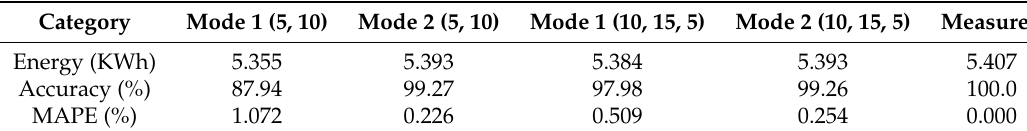
Table 1. Comparison with the set of neural network models.